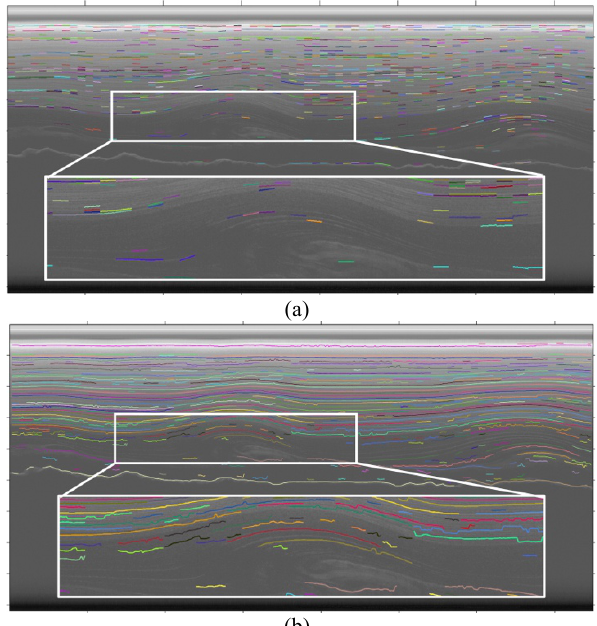
Figure 9. Comparison between extracted linear features along radar echogram AA’ by (a) block processing and (b) slice processing (block size is 50 × 50 pixels, and slice width is 20 pixels with a step of 6